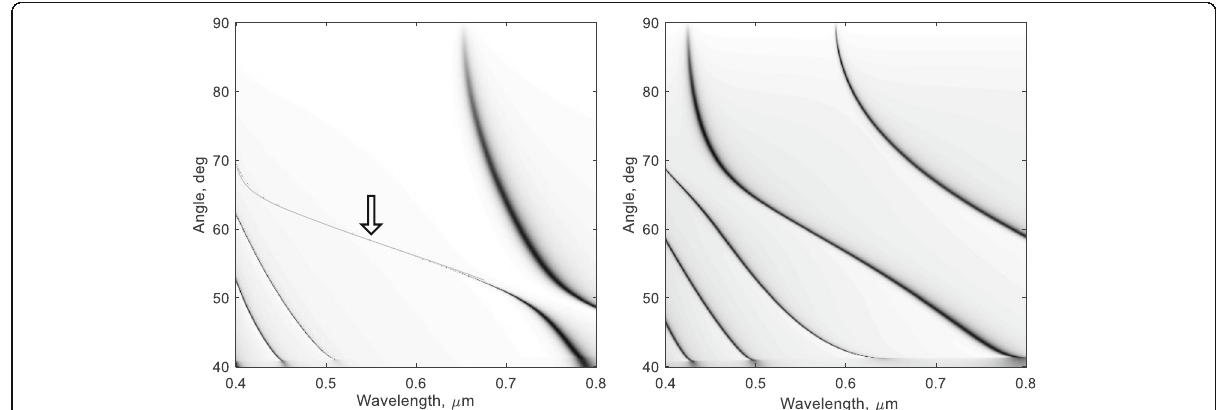
Fig. 3 Relationship between incident angles and wavelengths for TE waveguide modes ( left ) and TM hybrid plasmonic modes ( right ). Arrow indicates the narrowest waveguide